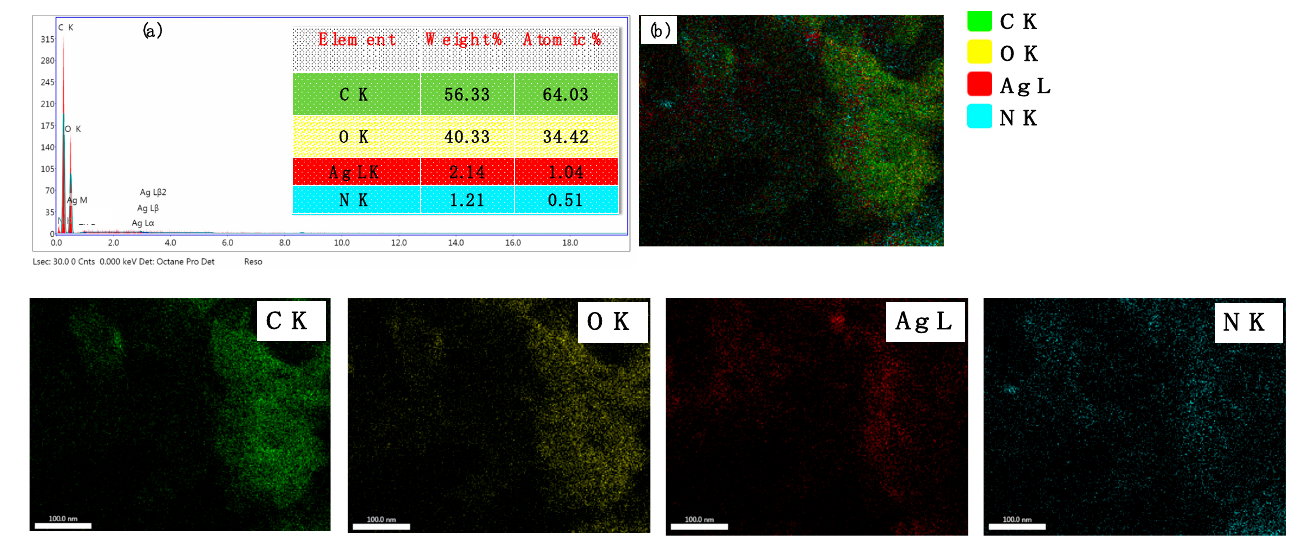
Figure 4. EDX and mapping of AgNPs-0@NFs. The element analysis, weight, and atomic percent ( a , b )